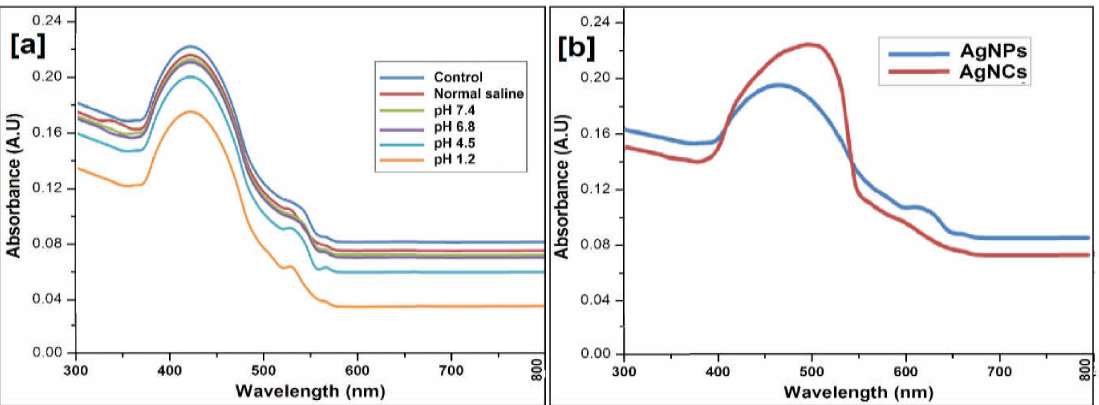
Figure 7. In vitro stability evaluated by UV–Vis spectrophotometry at room temperature for ( a ) AgNCs exposed to 1X PBS for 48 h at indicated pH, and normal saline (0.9% NaCl); ( b ) AgNPs and conjugated with